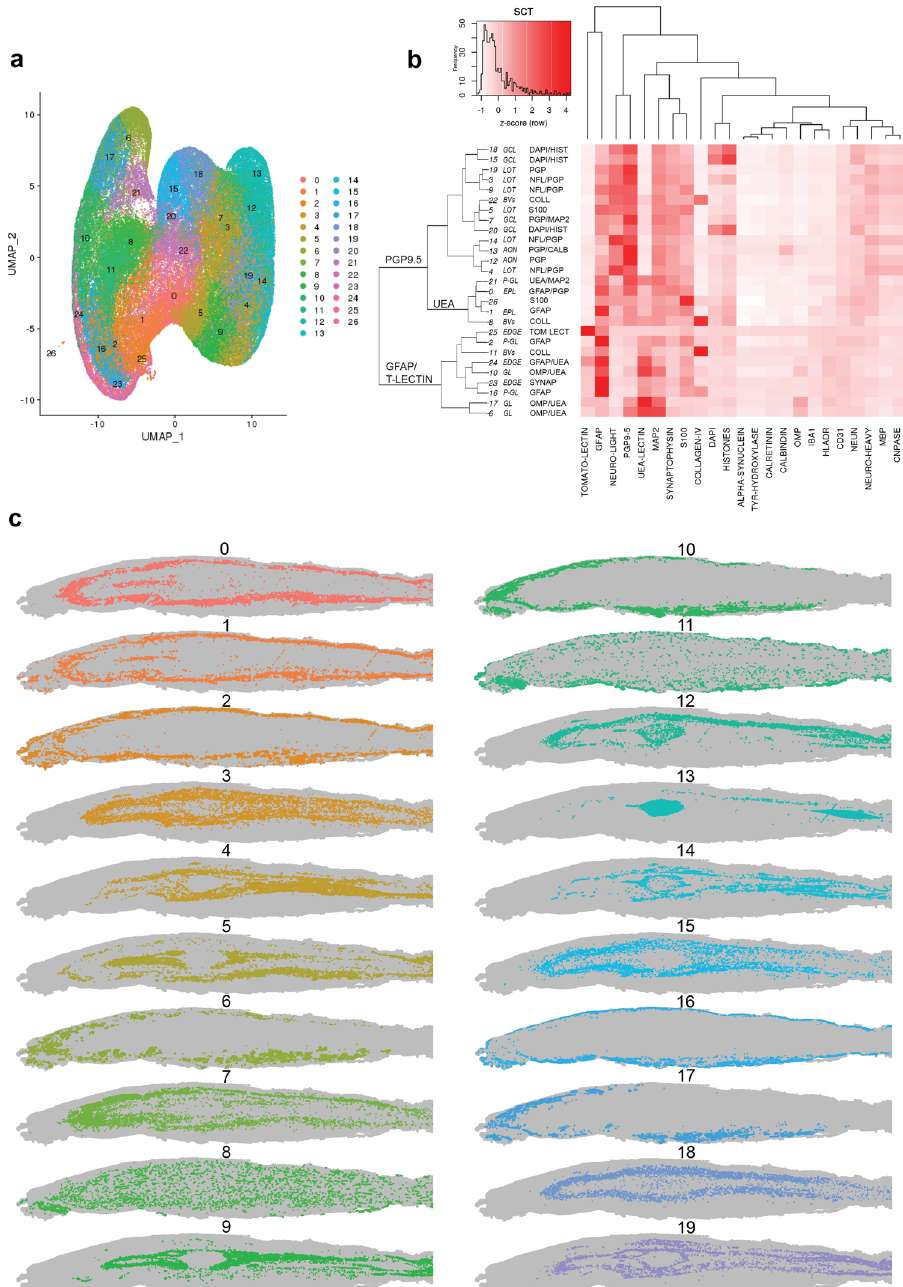
Fig. 3 Individual section cluster analysis for NSP case H190. a UMAP of pixel bin data coloured by cluster. b Heat map of z-score of labelling intensity for markers within each cluster. Clusters are organised based on a hierarchical tree. Each cluster is identi fi ed by a number and a three-letter code indicating the layer it is localised to, based on visual inspection of the slide plot for that cluster, as well as the one or two most intensely labelled or distinct markers for that cluster. c Individual slide plots of clusters 0 – 19 illustrating the unique spatial distribution of each cluster. AON anterior olfactory nucleus, BVs blood vessels. EPL external plexiform layer, GL glomerular layer, GCL granule cell layer, LOT lateral olfactory tract, P-GL